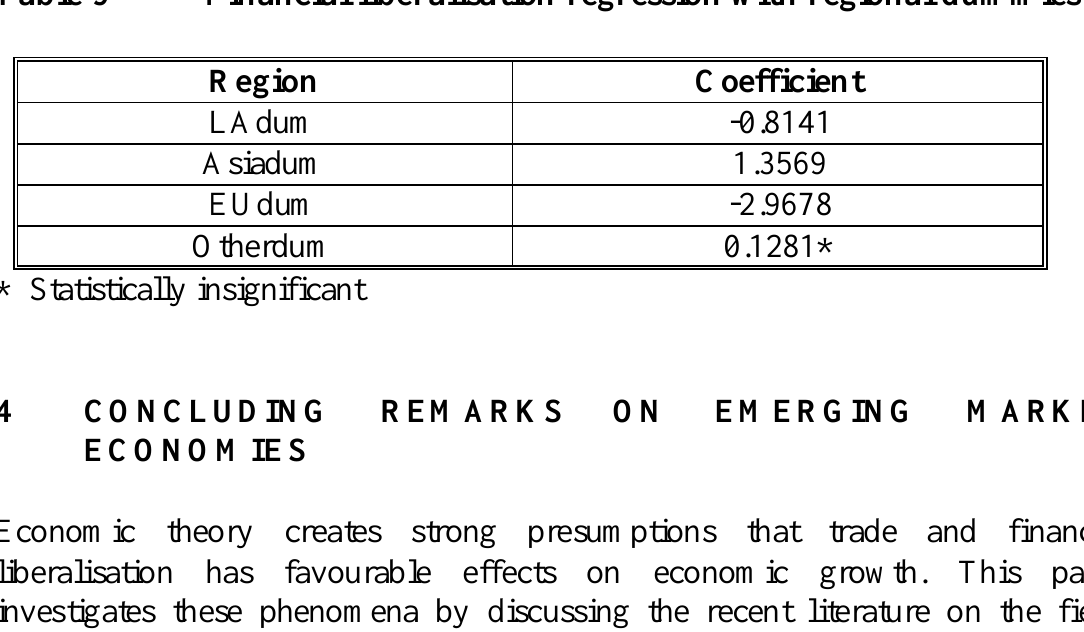
Financial liberalisation regression with regional